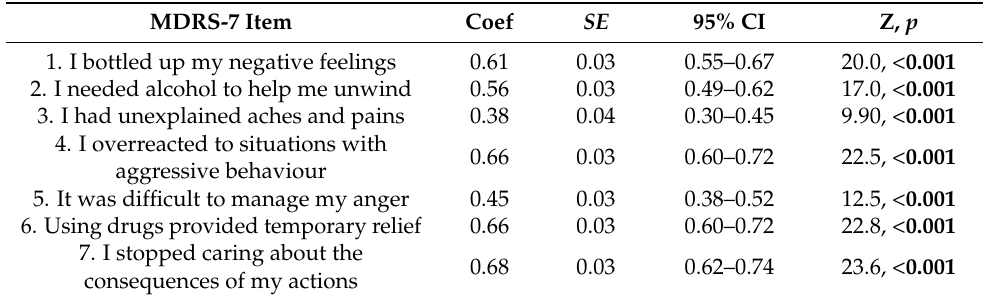
Table 1. Standardised CFA loadings for MDRS-7 items ( n = 709).